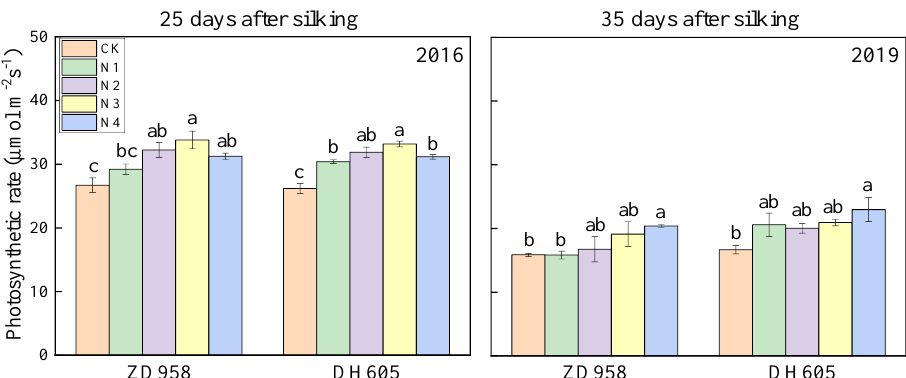
Figure 2. Effects of N treatments on photosynthetic rate of ear leaves in maize in 2016 and 2019. One-way analysis of variance with Duncan’s new multiple range test was conducted to assess the statistical patterns. Different letters indicate a significant difference ( p < 0.05).